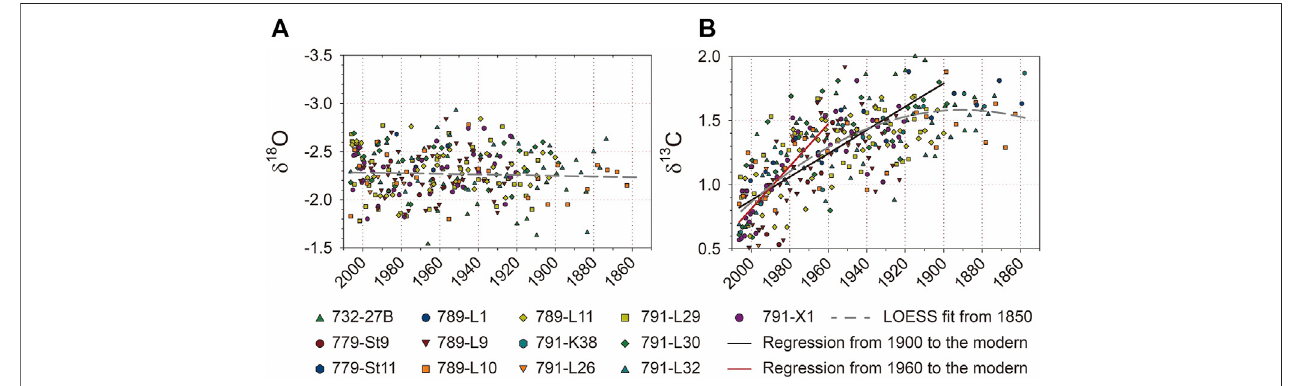
FIGURE 3 | δ 18 O and δ 13 C derived from planktonic foraminifera G. sacculifer of 13 box cores are shown in (A) and (B) , respectively. LOESS fi t from 1850 to the present was plotted as the gray line. Linear regressions of δ 13 C from 1900 to the present and from 1960 to the present were plotted as blue and red lines, respectively. Different symbols with colors indicate box cores collected near